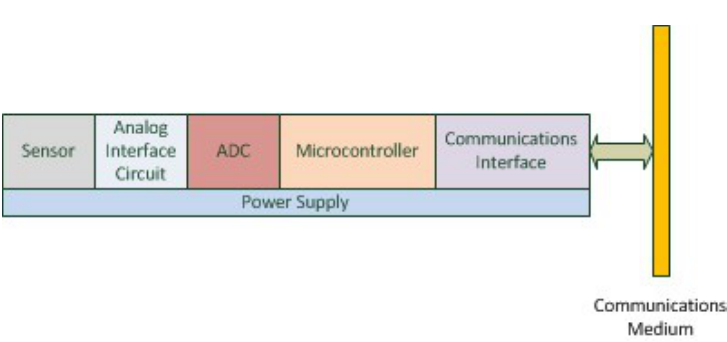
Figure 5. Smart sensor block